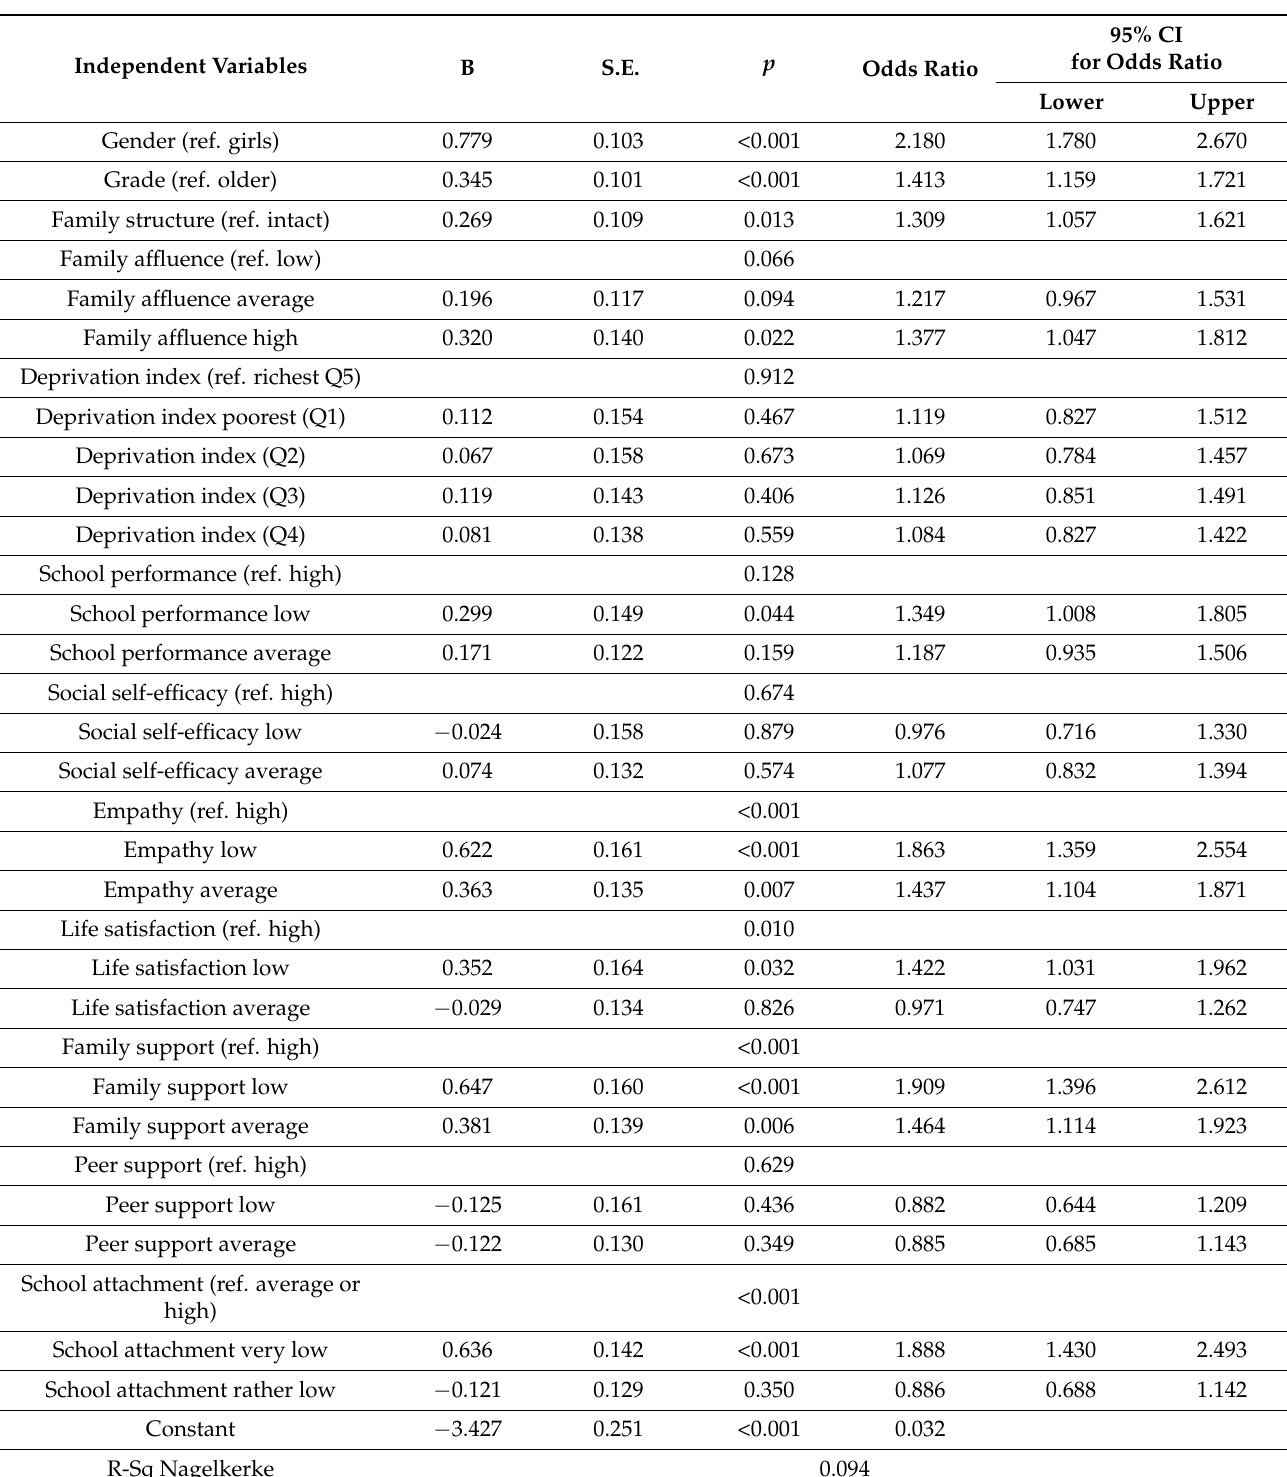
Table 6. Logistic regression predicting likelihood of cyberbullying